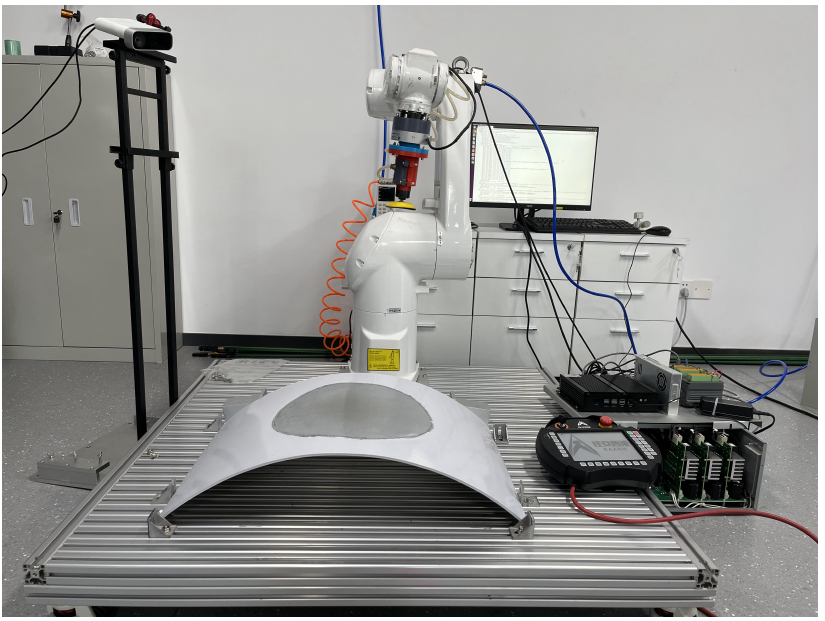
Figure 22. The experimental